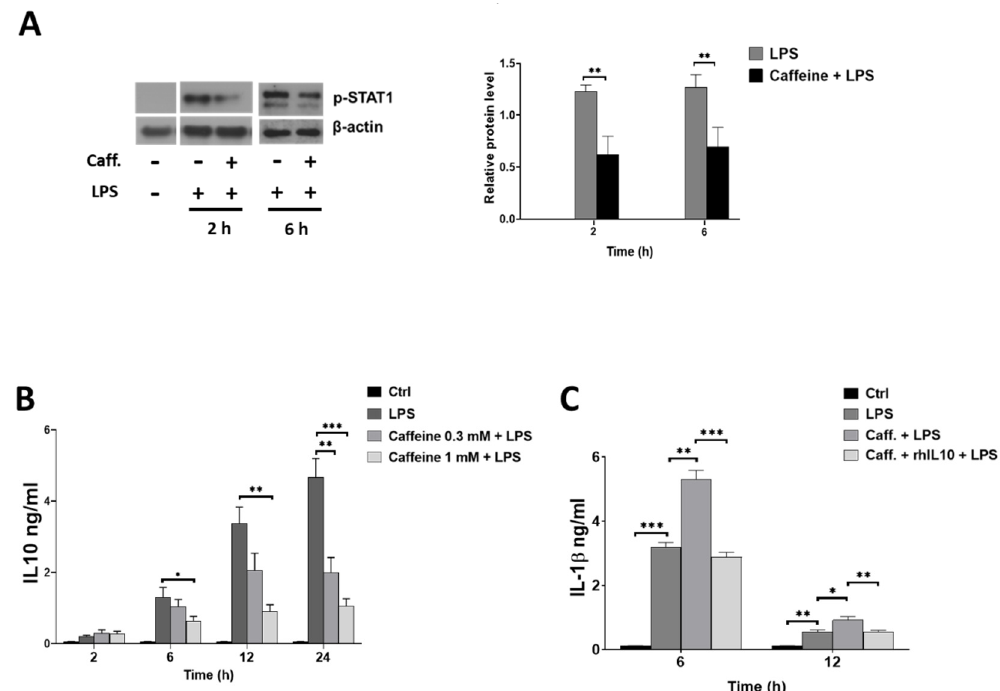
Figure 6. Caffeine modulates IL-10 and STAT1 signaling in M-M Φ s. Cells were pre-treated with caffeine (0.3 mM or 1 mM) for 1 h, then stimulated with LPS (100 ng/mL) for the indicated time. ( A ) Representative immunoblots of phosphorylated STAT1 obtained from cell lysates of M-M Φ s and bar graph represents the relative protein expression determined by densitometry. ( B ) IL-10 secretion was determined by ELISA from cell culture supernatants. ( C ) The cells were pre-treated with recombinant human IL-10 (rhIL-10) (100 ng/mL) 1 h before LPS activation and IL-1 β secretion was determined by ELISA from cell culture supernatants. All results are shown as means ± SEM. (* p < 0.05, ** p < 0.01, *** p < 0.001).